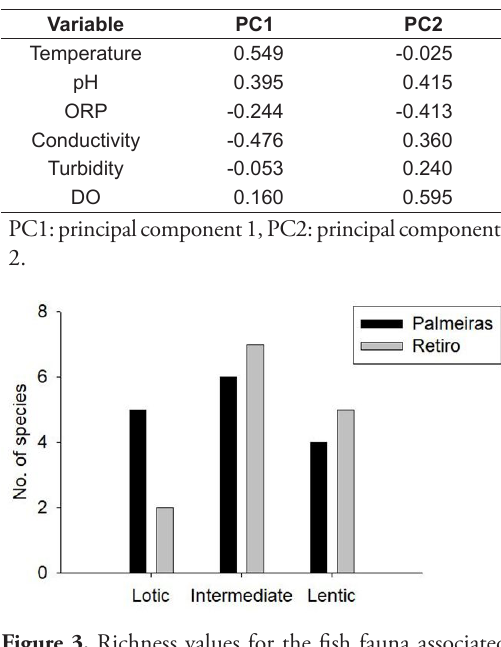
Figure 3. Richness values for the fish fauna associated to macrophyte banks in the distinct compartments of Palmeiras and Retiro SHPs reservoirs, Sapucaí-Mirim River (SP, Brazil).